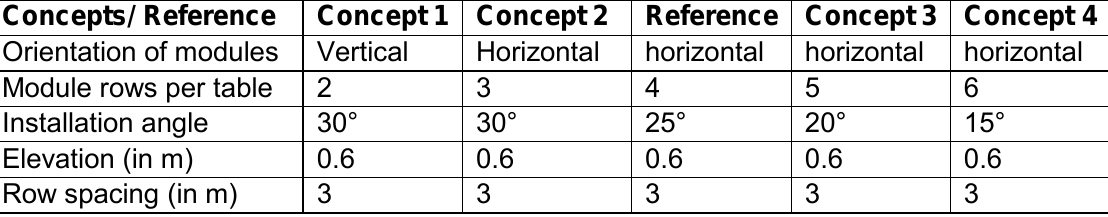
Table 1. Comparison of the system concepts [own